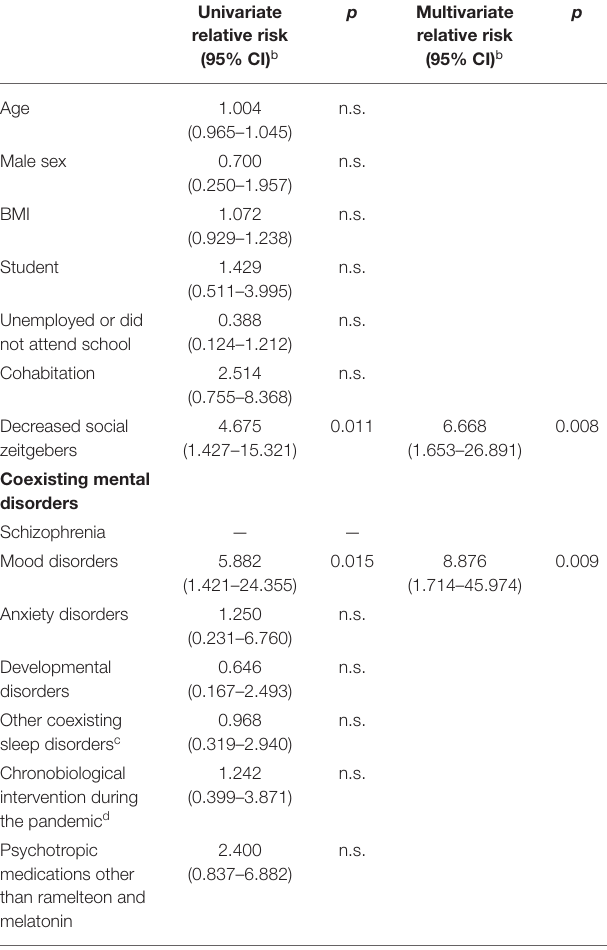
TABLE 3 | Factors associated with worsened DSWPD symptoms a . TABLE 4 | Breakdown of chronobiological intervention during the COVID-19 pandemic, baseline severity of DSWPD, and changes in